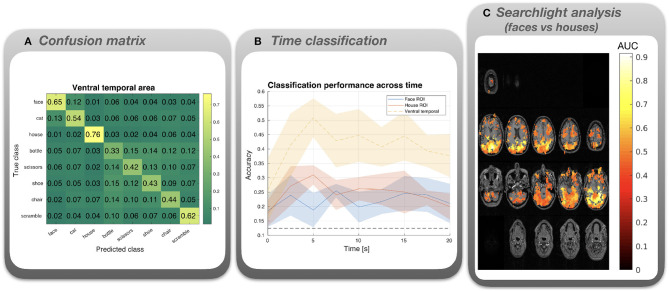
Results for the classification analysis of the Haxby et al. (2001) fMRI data. (A) Confusion matrix for multi-class (8 classes) classification based on voxels in the ventral temporal area, averaged across subjects. (B) Multi-class (8 classes) classification accuracy was calculated for each time point following stimulus onset. Lines depict means across subjects, shaded areas correspond to standard error. Masks were used to select voxels in the ventral temporal area (yellow line), voxels responsive to faces (blue), or voxels responsive to houses (red). (C) Cluster permutation test results based on a searchlight analysis using a binary classifier (faces vs houses). Red spots represent AUC values superimposed on axial slices of the averaged structural MRI. All depicted AUC values correspond to the significant cluster; other AUC values have been masked out.